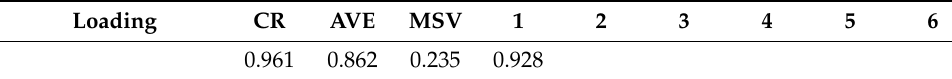
Table 2. Results of convergent and discriminant